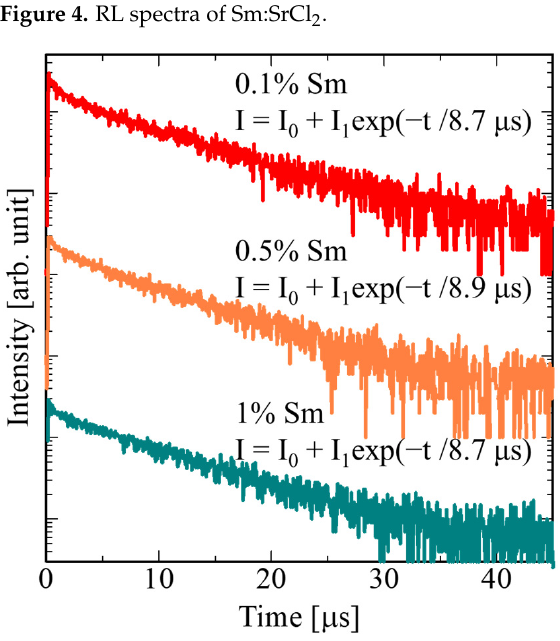
Figure 5. RL decay curves of Sm:SrCl 2 .